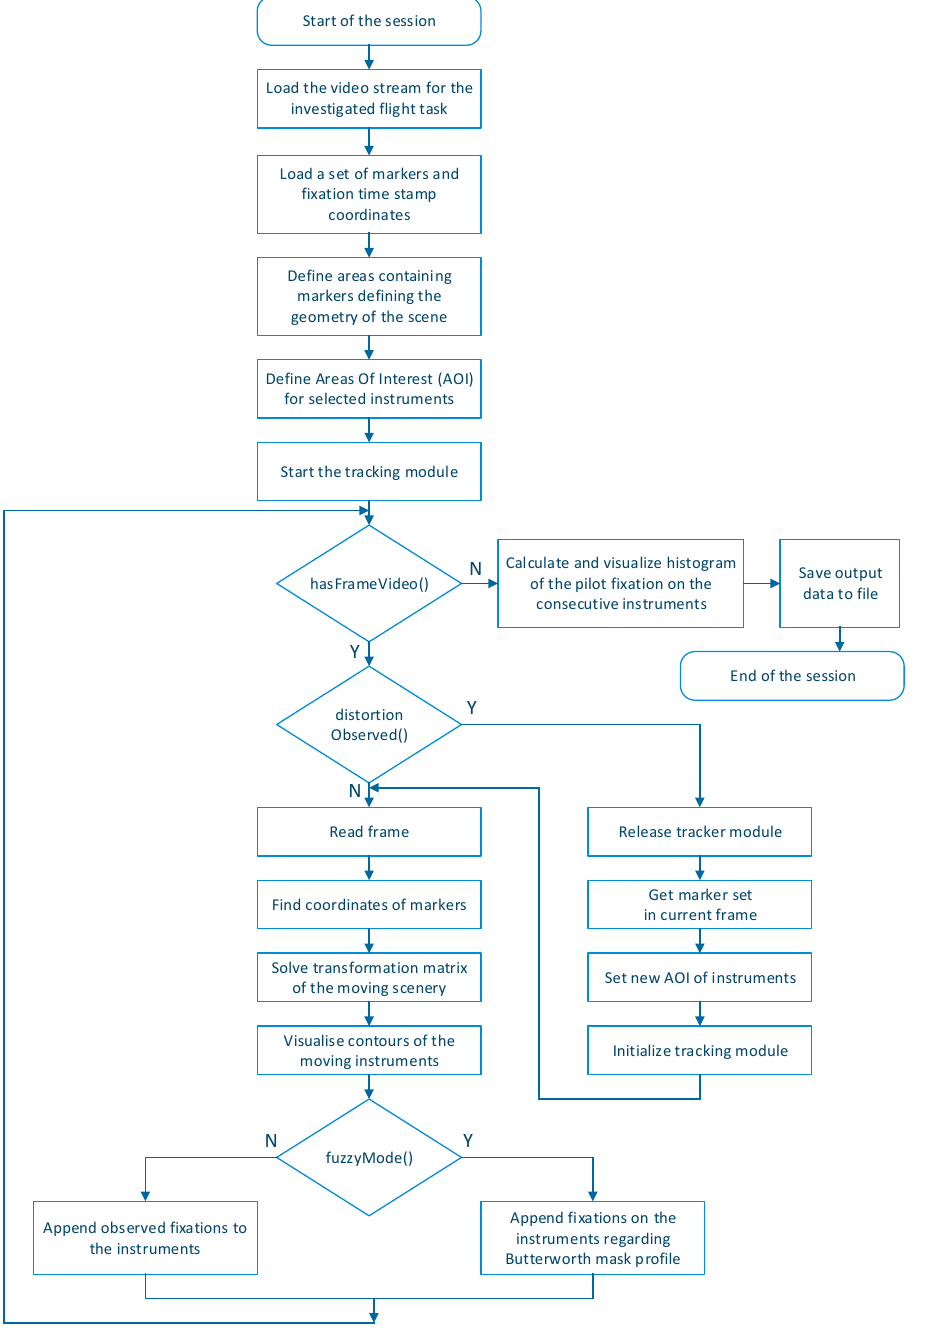
Figure 8. The operation scheme of the designed